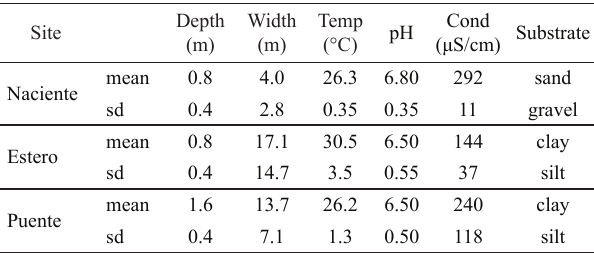
Tab. 1. Mean and standard deviation (sd) of depth,